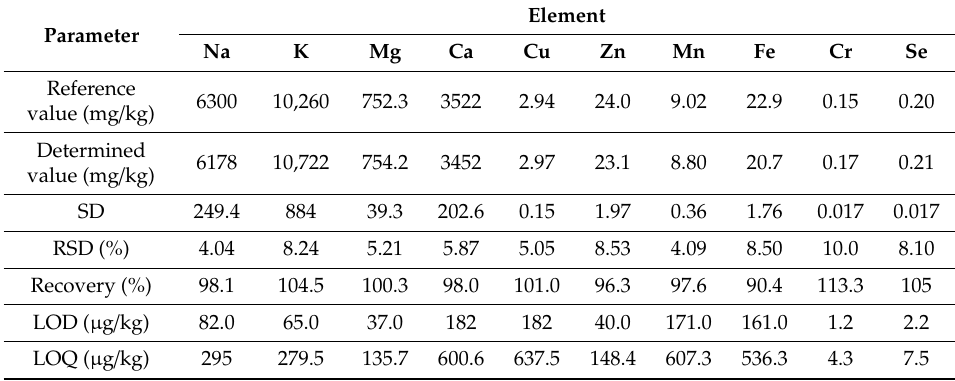
Table 2. Selective parameters of the applied spectroscopic